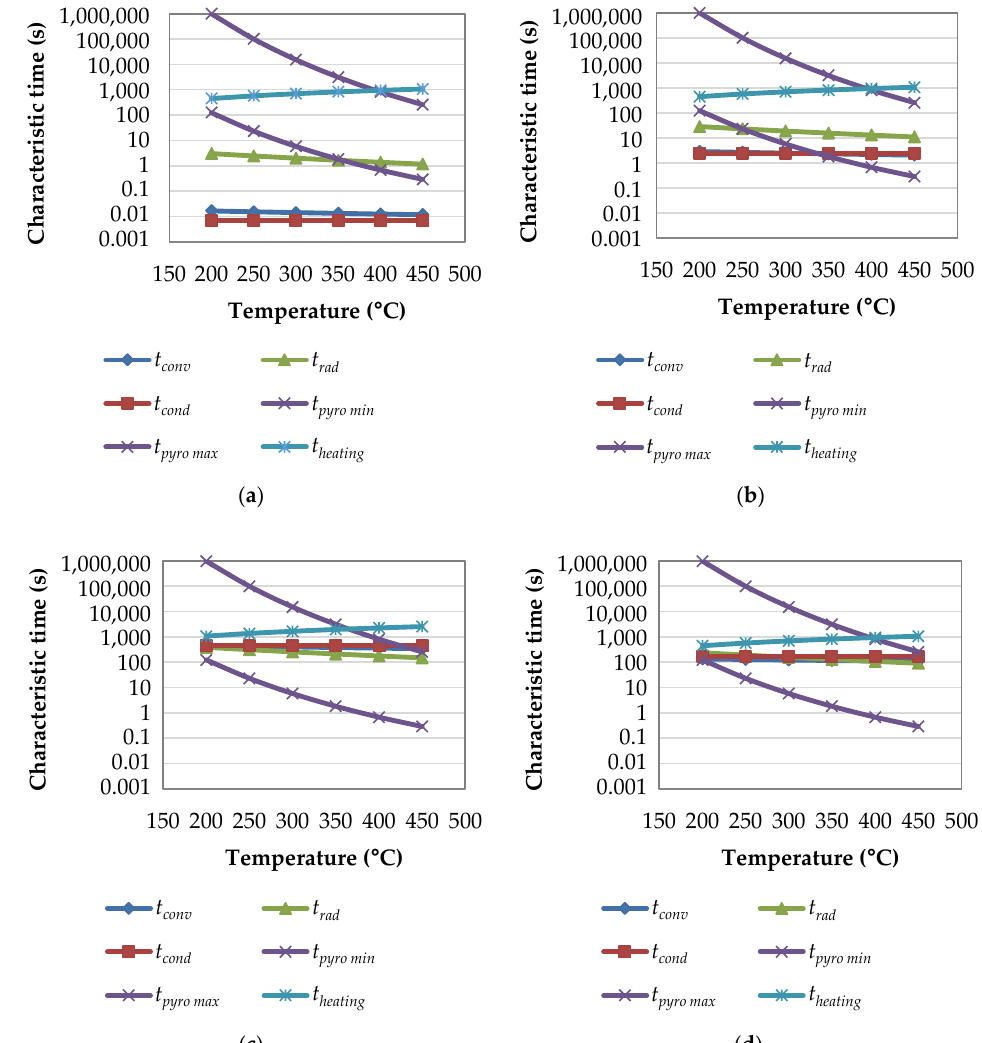
Figure 3. Characteristic times of the pyrolysis step as a function of temperature for: ( a ) particle scale in TGA conditions; ( b ) bed scale in TGA conditions; ( c ) bed scale in device M conditions; and ( d ) bed scale in device P condition. TGA: thermogravimetric analysis.